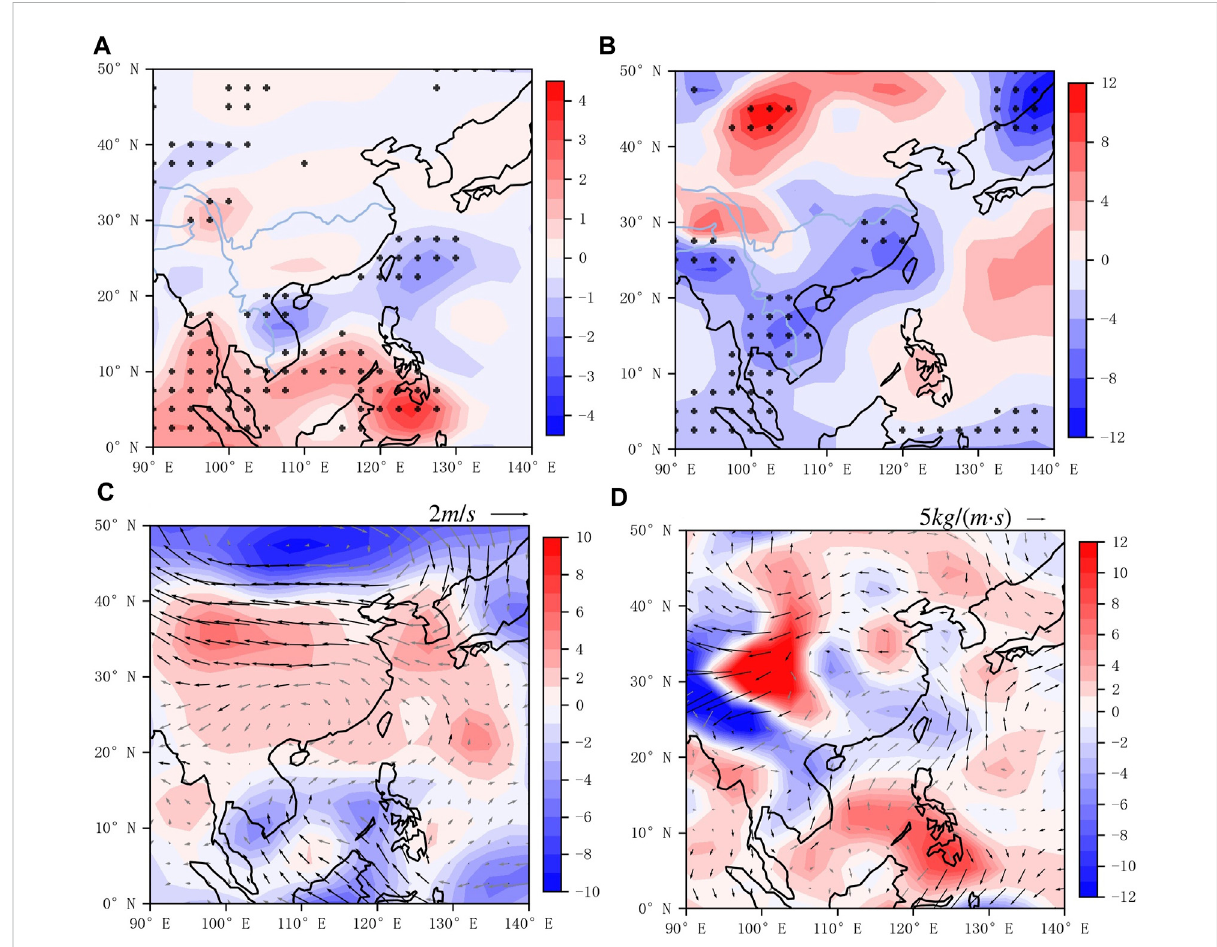
FIGURE 5 Interdecadal difference between P1 and P2 periods (P2-P1): 500 hPa vertical velocity (A) ; sea level pressure (B) ; 850 hPa wind fi eld and relative vorticity (C) ; 1000 – 500 hPa water vapor fl ux and water vapor fl ux divergence (D) . Dotted areas and black wind arrowsindicate values exceeding the 95% con fi dence level by t